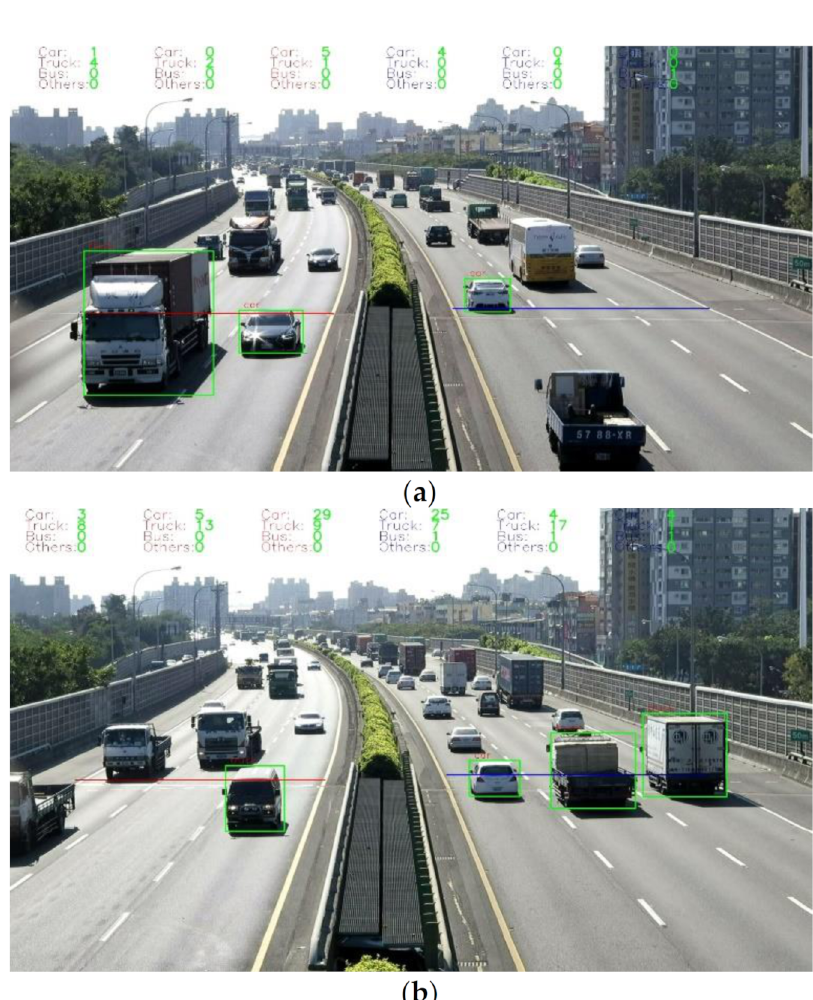
Figure 9. The results of vehicle counting in both the northbound and southbound lanes from the video taken on National Freeway No.1 ( a , b ). The red line represents the connected virtual lines in the three northbound lanes, while the blue line represents the connected virtual lines in the three southbound lanes. The green boxes mark the vehicles tracked in the hot zones.